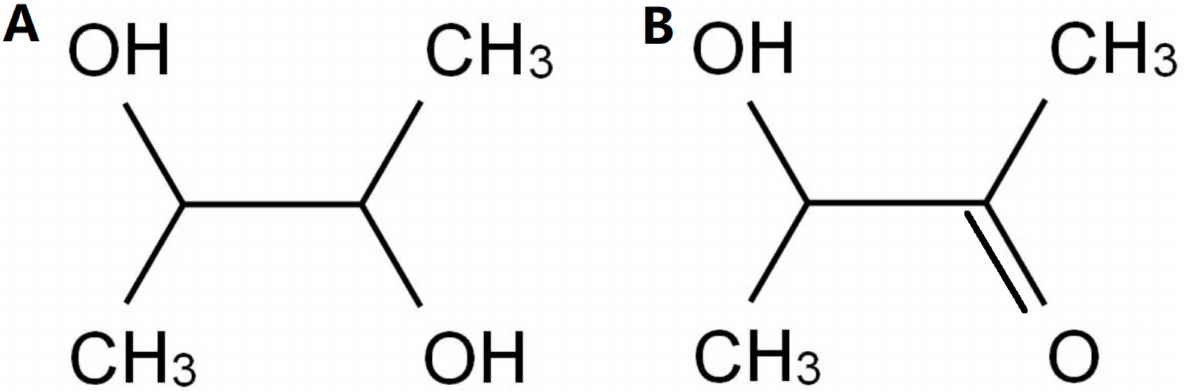
Figure 1. The structure of 2,3-butanediol ( A ) and acetoin ( B